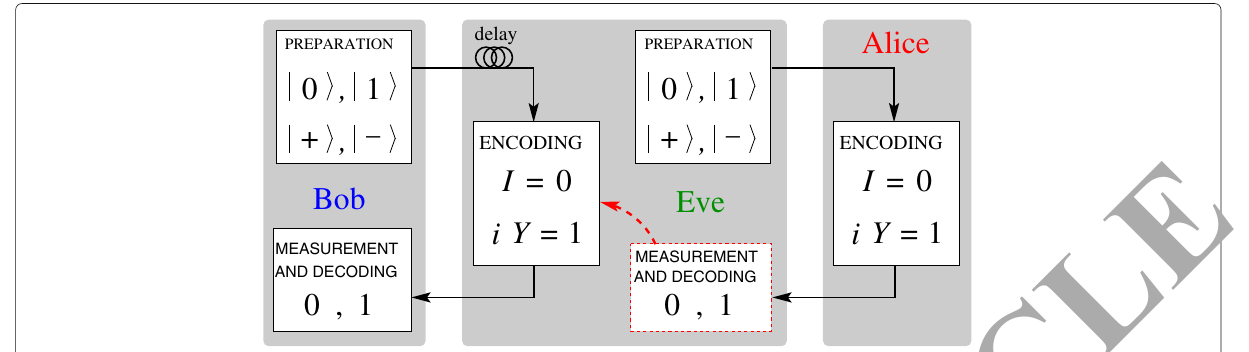
Fig. 4 Lucamarini’s attack on the LM05 protocol. Schematics are made according to [18, p. 61,Fig. 5.5]